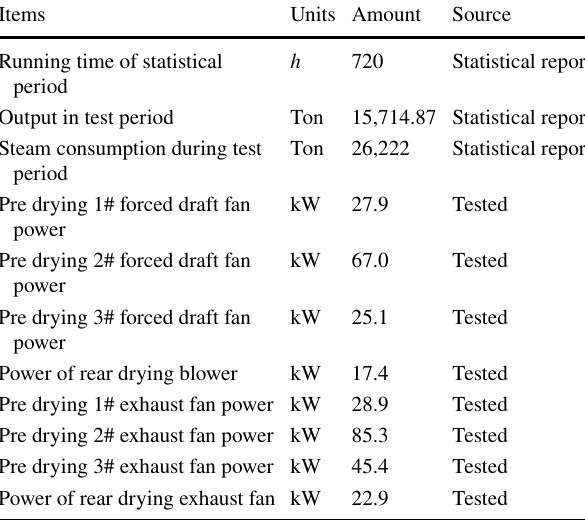
Table 2 Energy consumption test during the test